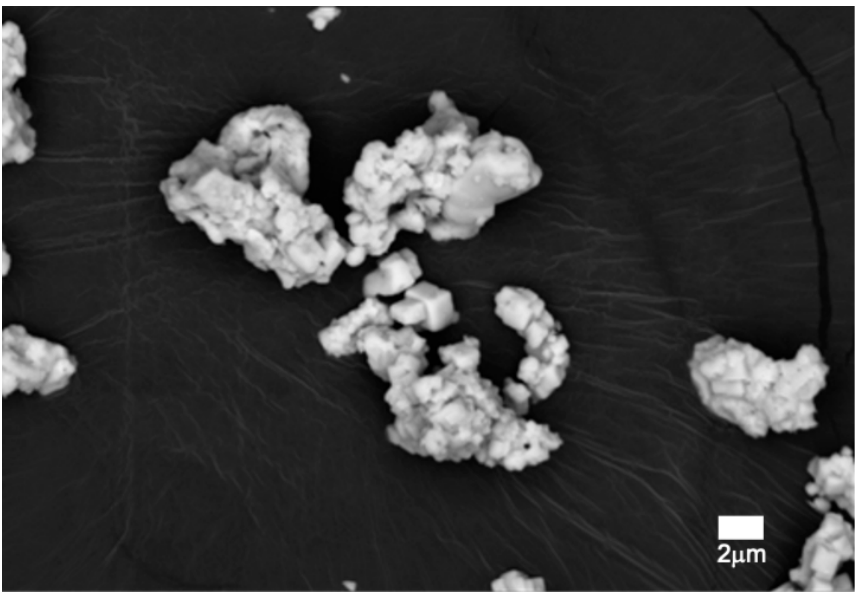
Figure 14. SEM micrography with backscattered detector of pigment Y 0.98 Al 0.98 Cr 0.04 O 3 fired at 1500 °C.